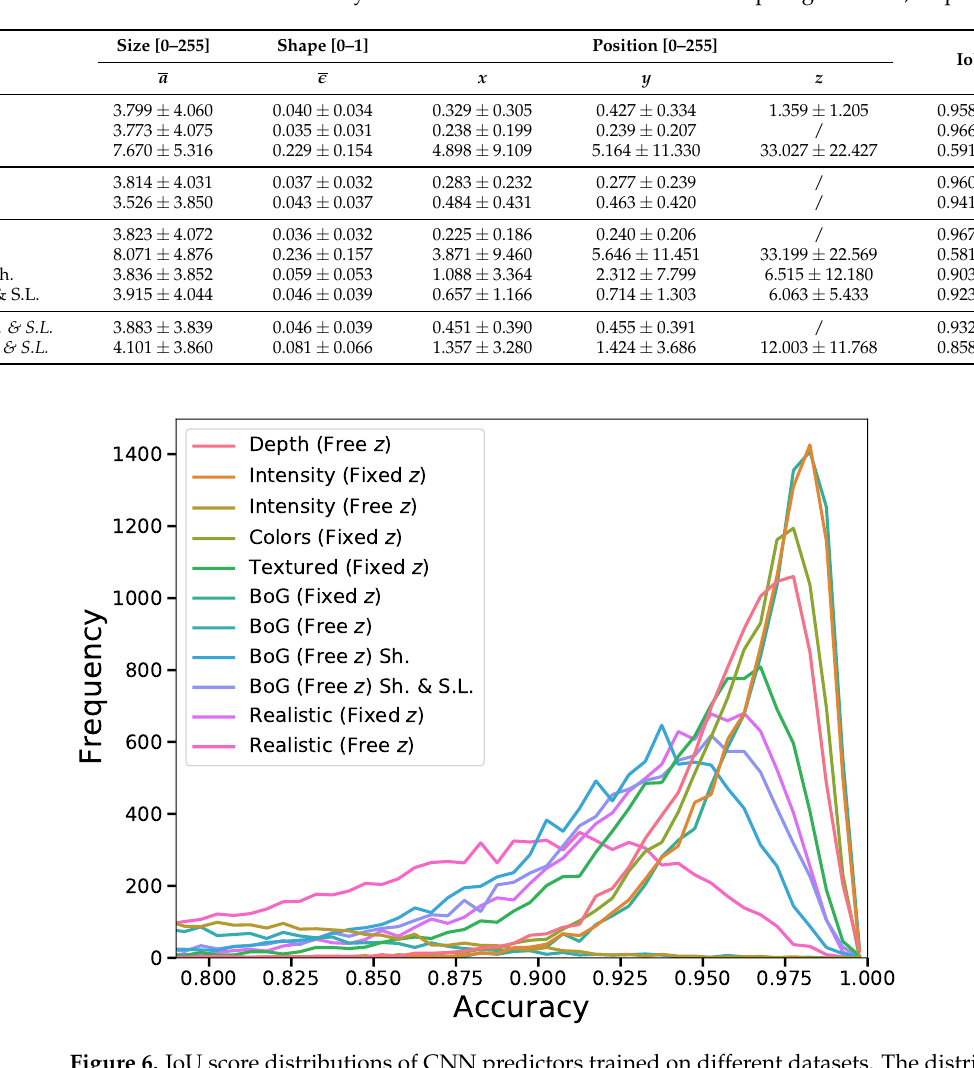
Table 1. The table reports the mean and standard deviation values of the mean absolute error(s) (MAE) and IoU accuracies of the predictions on the test set. Size ( a ) and shape ( (cid:101) ) errors are averaged over all elements of the parameter group, due to the arbitrary ordering discussed before. Some z errors are crossed out for clarity since some datasets included Fixed z parameter values. The abbreviations Sh. and S.L. denote the ability to cast shadows and the addition of a spotlight source, respectively.